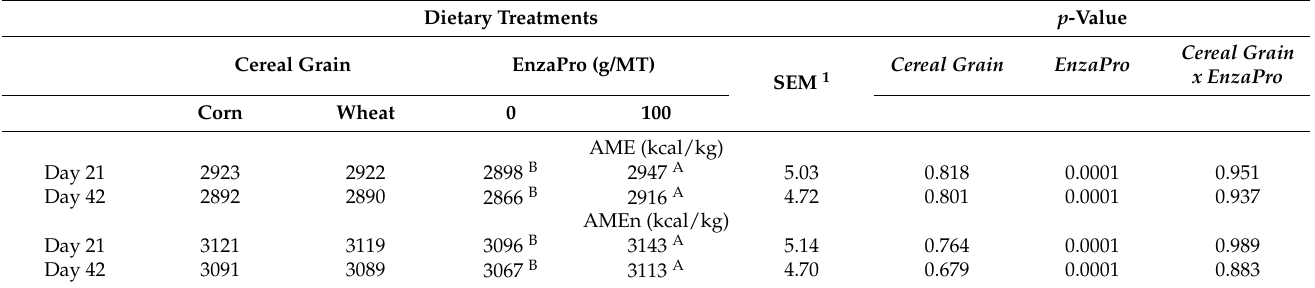
Table 3. Least-square means for apparent metabolizable energy (AME) and apparent metabolizable energy corrected for nitrogen (AMEn) for broilers raised to 42